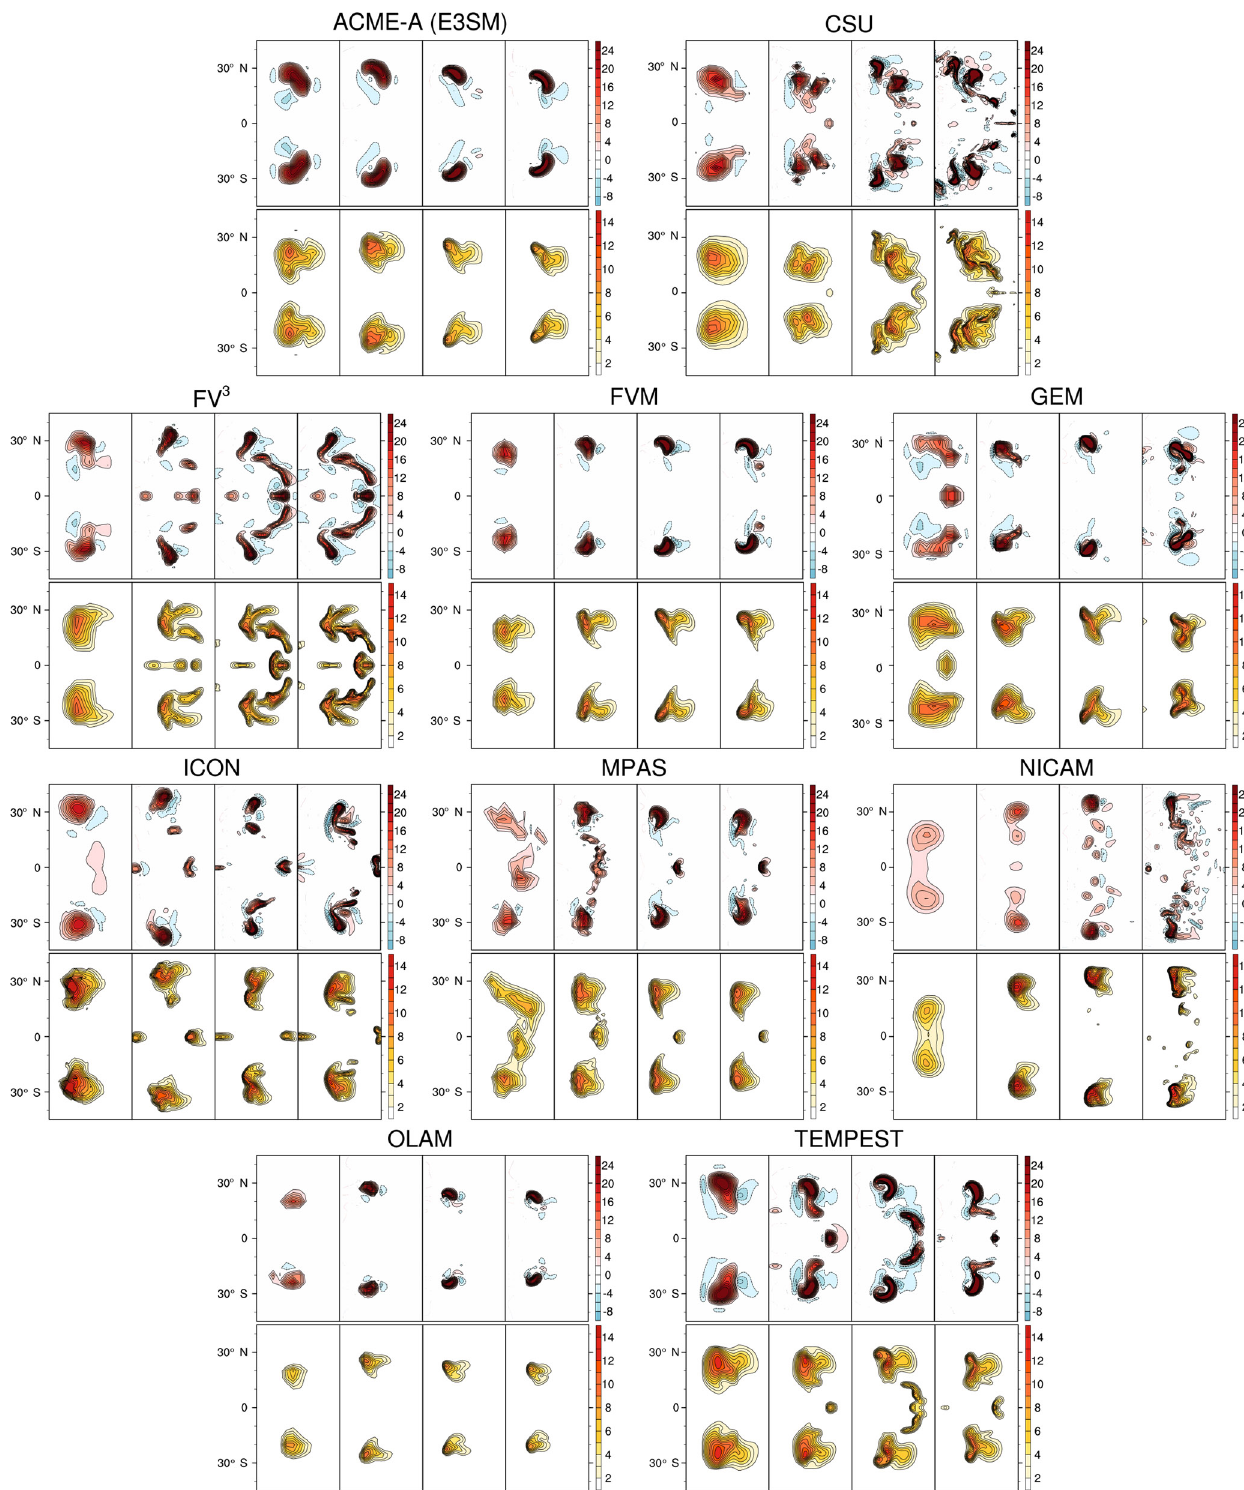
Figure 4. Resolution sensitivity of cross-sections of 5km vertical velocity (ms − 1 , top) and 5km rainwater (gkg − 1 , bottom) plotted at 120min for each model. From left to right, nominal model resolutions are 4, 2, 1, and